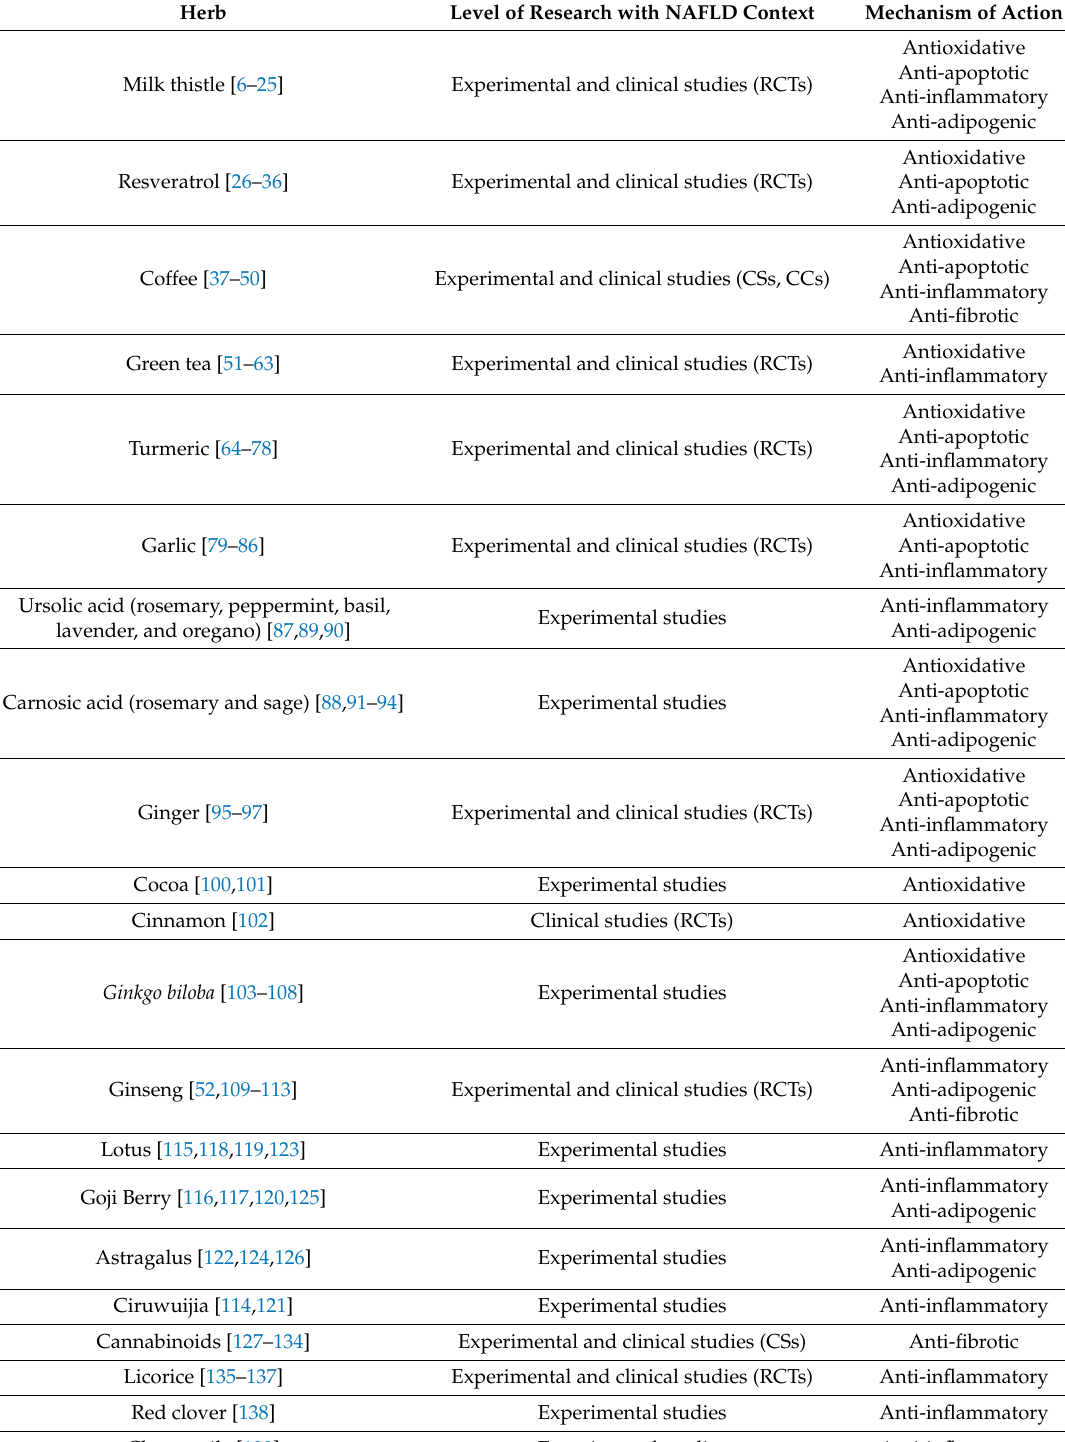
Table 1. The extent of research for each herb in the setting of nonalcoholic fatty liver disease (NAFLD)